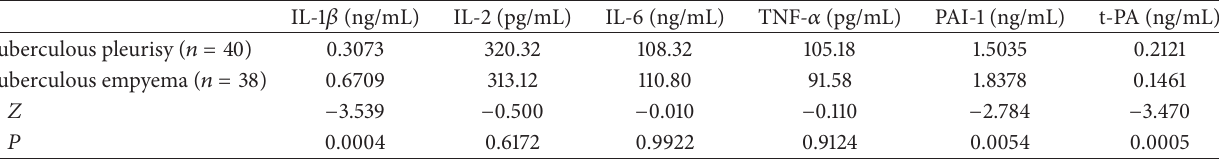
Table 1: IL-1 𝛽 , IL-2, IL-6, TNF- 𝛼 , PAI-1, and t-PA levels in the patients with tuberculous pleurisy and tuberculous empyema.